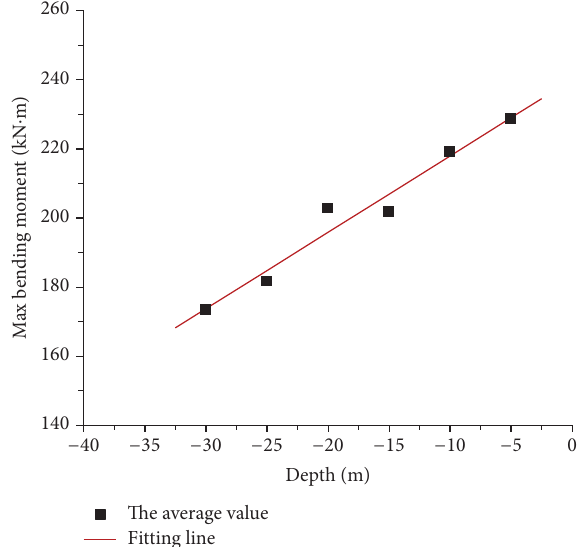
Figure 4: The relationship between the average value of the maximum bending moment and depth in subway station structure.